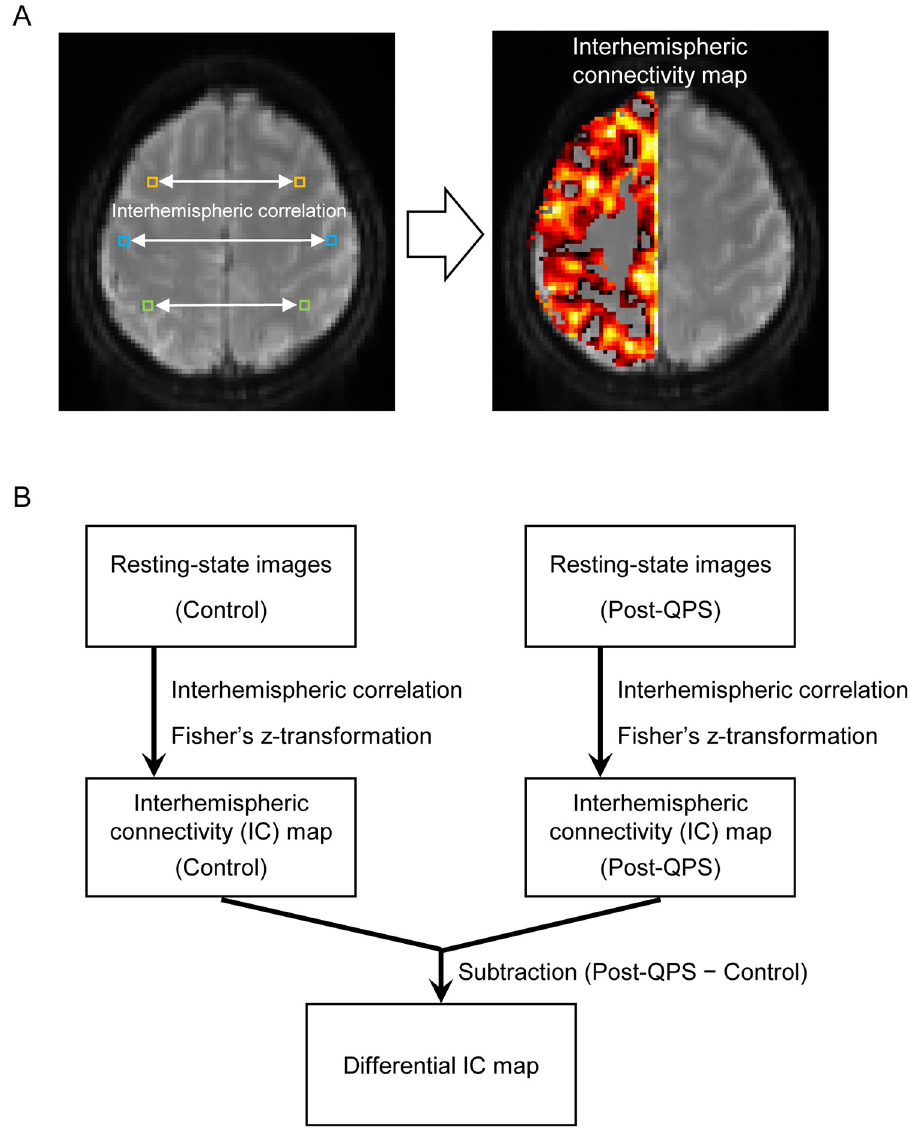
Fig 2. Interhemispheric functional connectivity analysis. (A) Each voxel in the left hemisphere of each subject was used as a seed to calculate its interhemispheric correlation with the corresponding voxel in the right hemisphere. The z values are shown only in the left hemisphere for display purposes. (B) The interhemispheric connectivity map of the post-QPS scans was calculated and was contrasted with that of the control scans to generate the differential interhemispheric connectivity map of each